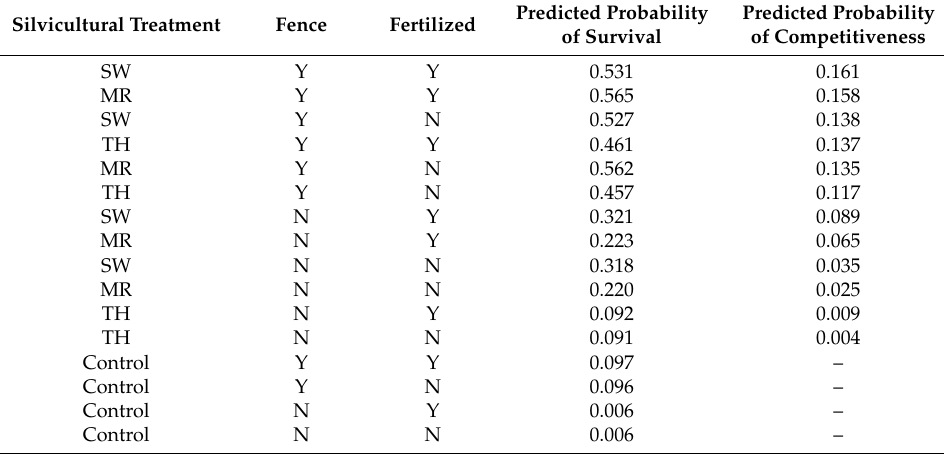
Table 3. Predicted probabilities of seedling survival and competitiveness generated from the most parsimonious mixed-effects logistic regression models for each response after ten years. Probability of competitiveness is relative to the number of seedlings initially planted. Treatments are listed in descending order by predicted probability of competitiveness. MR midstory removal; TH thinning; SW